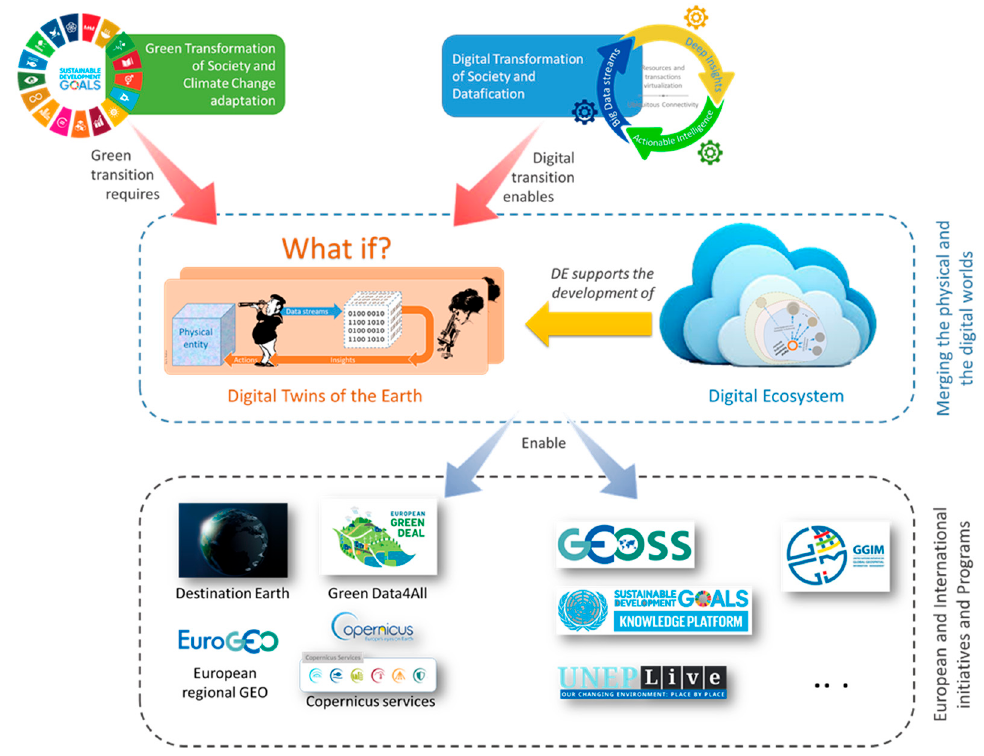
Figure 3. The role of DTs of the Earth in implementing the Green and the Digital transitions of society.